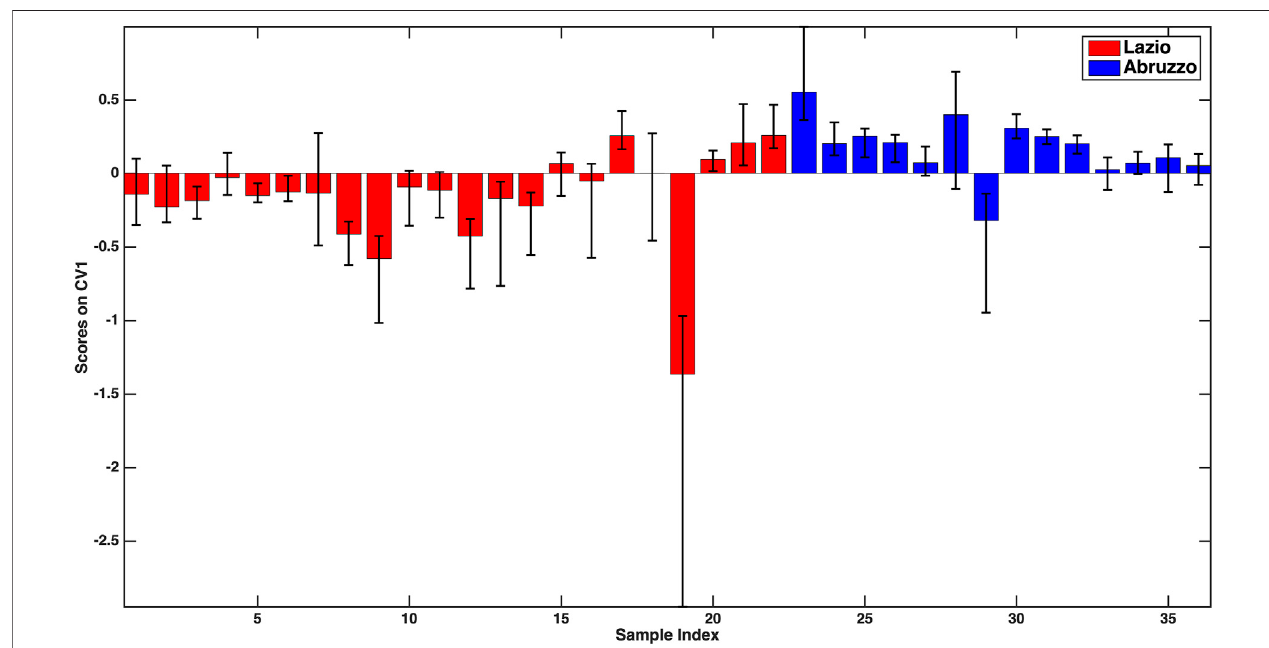
FIGURE 1 | – PLS-DA model for the discrimination between Lazio and Abruzzo samples: mean scores of the rDCV outer loop samples along the only canonical variate of the model together with their 95% con fi dence intervals. Legend: red bars – Lazio; blue bars – Abruzzo.